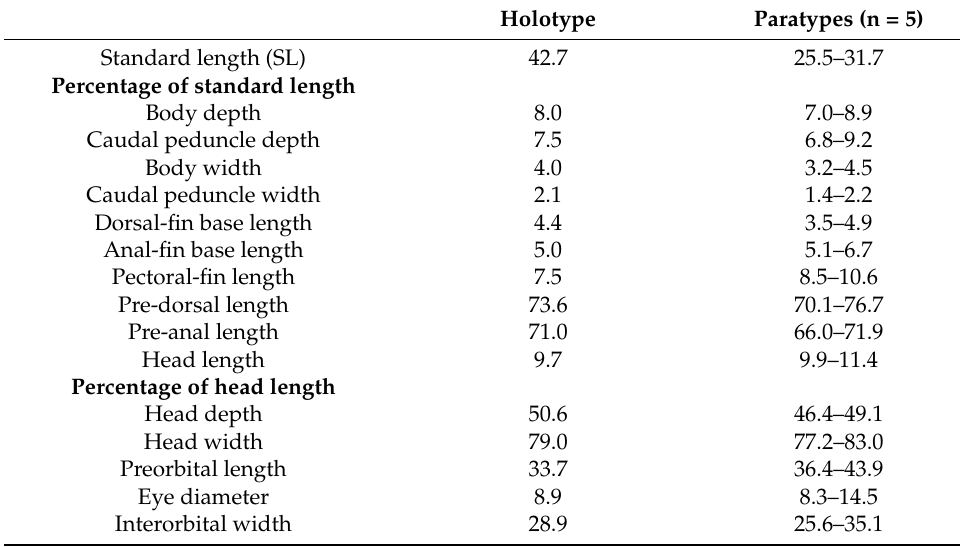
Table 1. Morphometric data of Listrura macaensis sp.